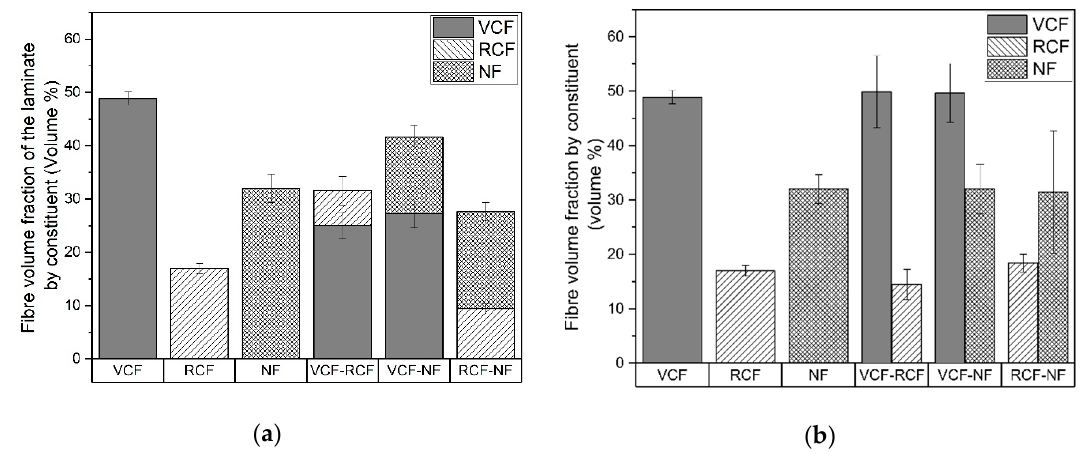
Figure 6. ( a ) Fiber volume fraction of the laminate by the fiber volume fraction of its constituent layers. ( b ) Fiber volume fraction of each constituent layer.